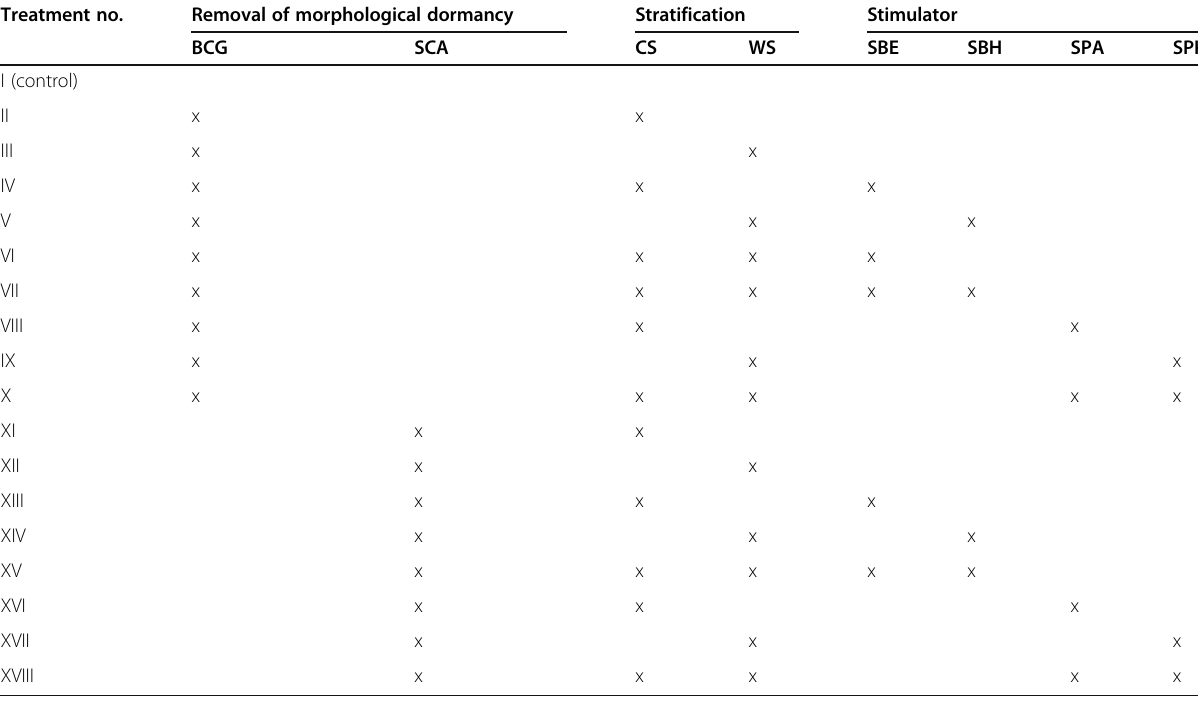
Table 1 Overview of pretreatment methods. All of them were applied separately to seeds originating from 1000, 1200, and 1400 m a.s.l.,